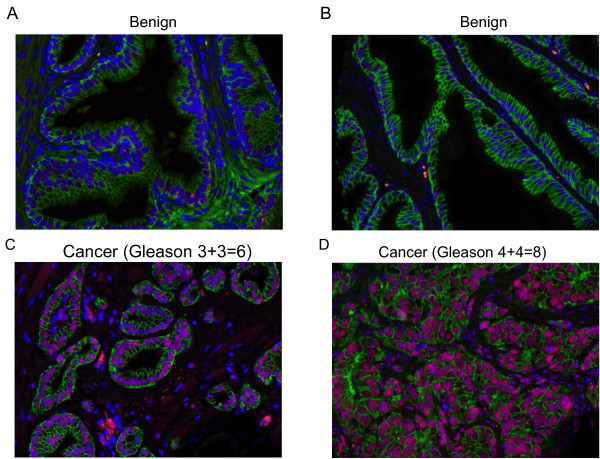
HP1γ expression in human prostate cancer is increased compared to benign normal prostate tissue. Tissue microarrays (336 cores) containing benign (A and B), HGPIN, low grade (C), high grade (D) and metastatic PCa were immunoflourescently stained for HP1γ (red). E-cadherin (green) labels epithelial cells and DAPI (blue) the cell nuclei. Increased staining is noted in PCa samples with nuclear expression greater than cytoplasmic. Low levels of HP1γ expression were infrequently observed in benign epithelial cells. In contrast, HP1γ was uniformly upregulated in the majority of prostate cancer cells.